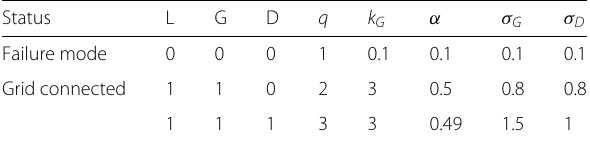
Table 1 Discrete status and continuous dynamics parameters Status